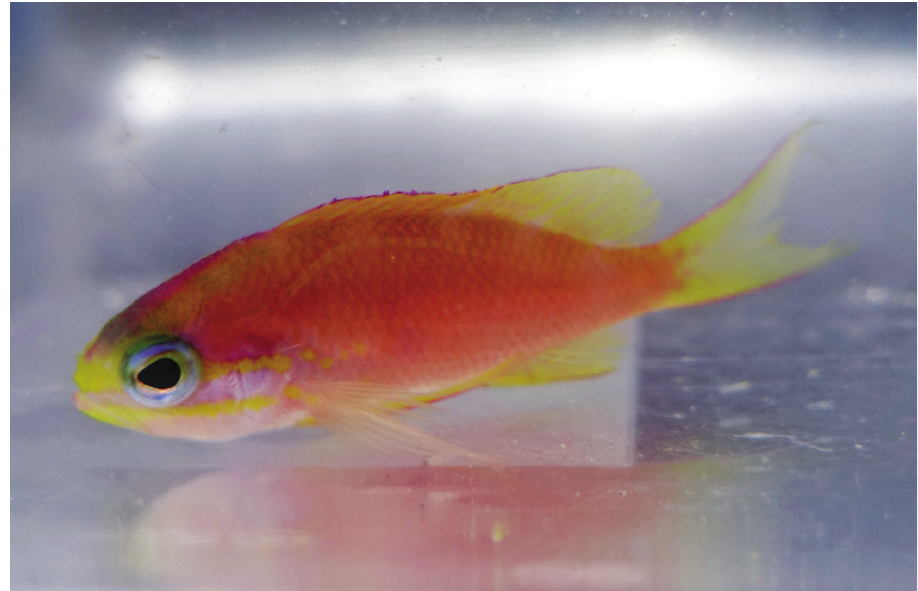
Figure 6. Paratype of Tosanoides obama shortly after collection, alive in a holding tank aboard the NOAA Ship Hi’ialakai . Photo by R. L.